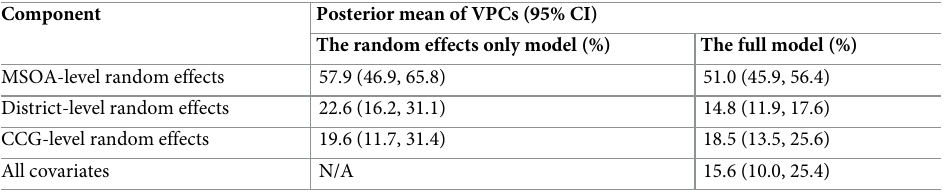
Table 4. Summary of the VPCs (posterior mean and 95% CI), percentage of the total variability explained by the 4 model components, the 3 sets of random effects and the covariates. Since the random effect only model does not include covariates, the VPC of the covariate component is 0%.